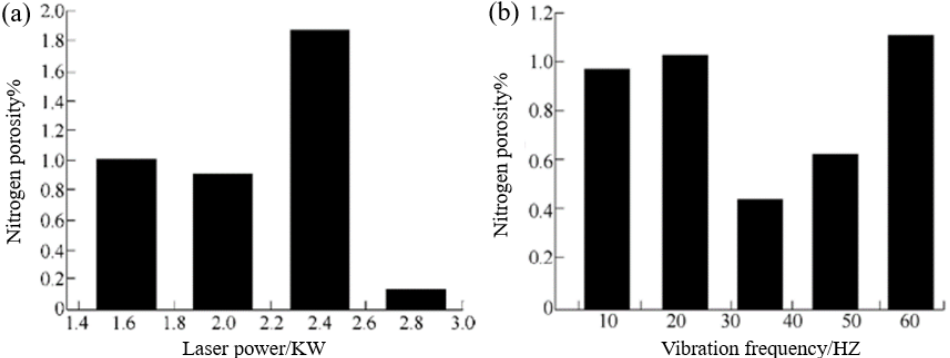
Figure 6. ( a ) Effect of laser power on porosities ( b ) Effect of vibration frequency on porosity. Reprinted with permission from ref. [22]. Copyright 2016, Journal of Mechanical